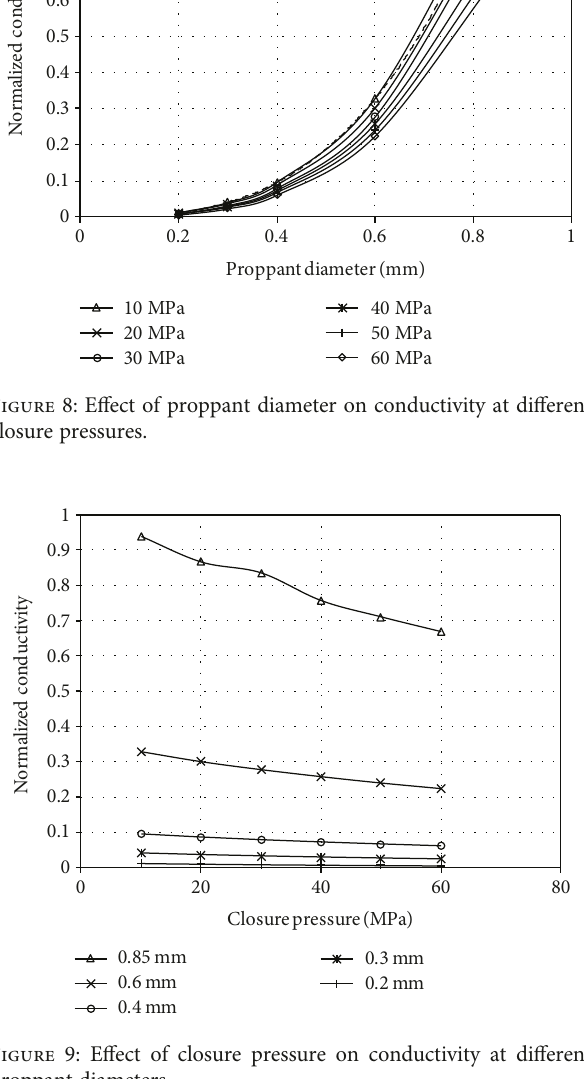
Figure 9: E ff ect of closure pressure on conductivity at di ff erent proppant